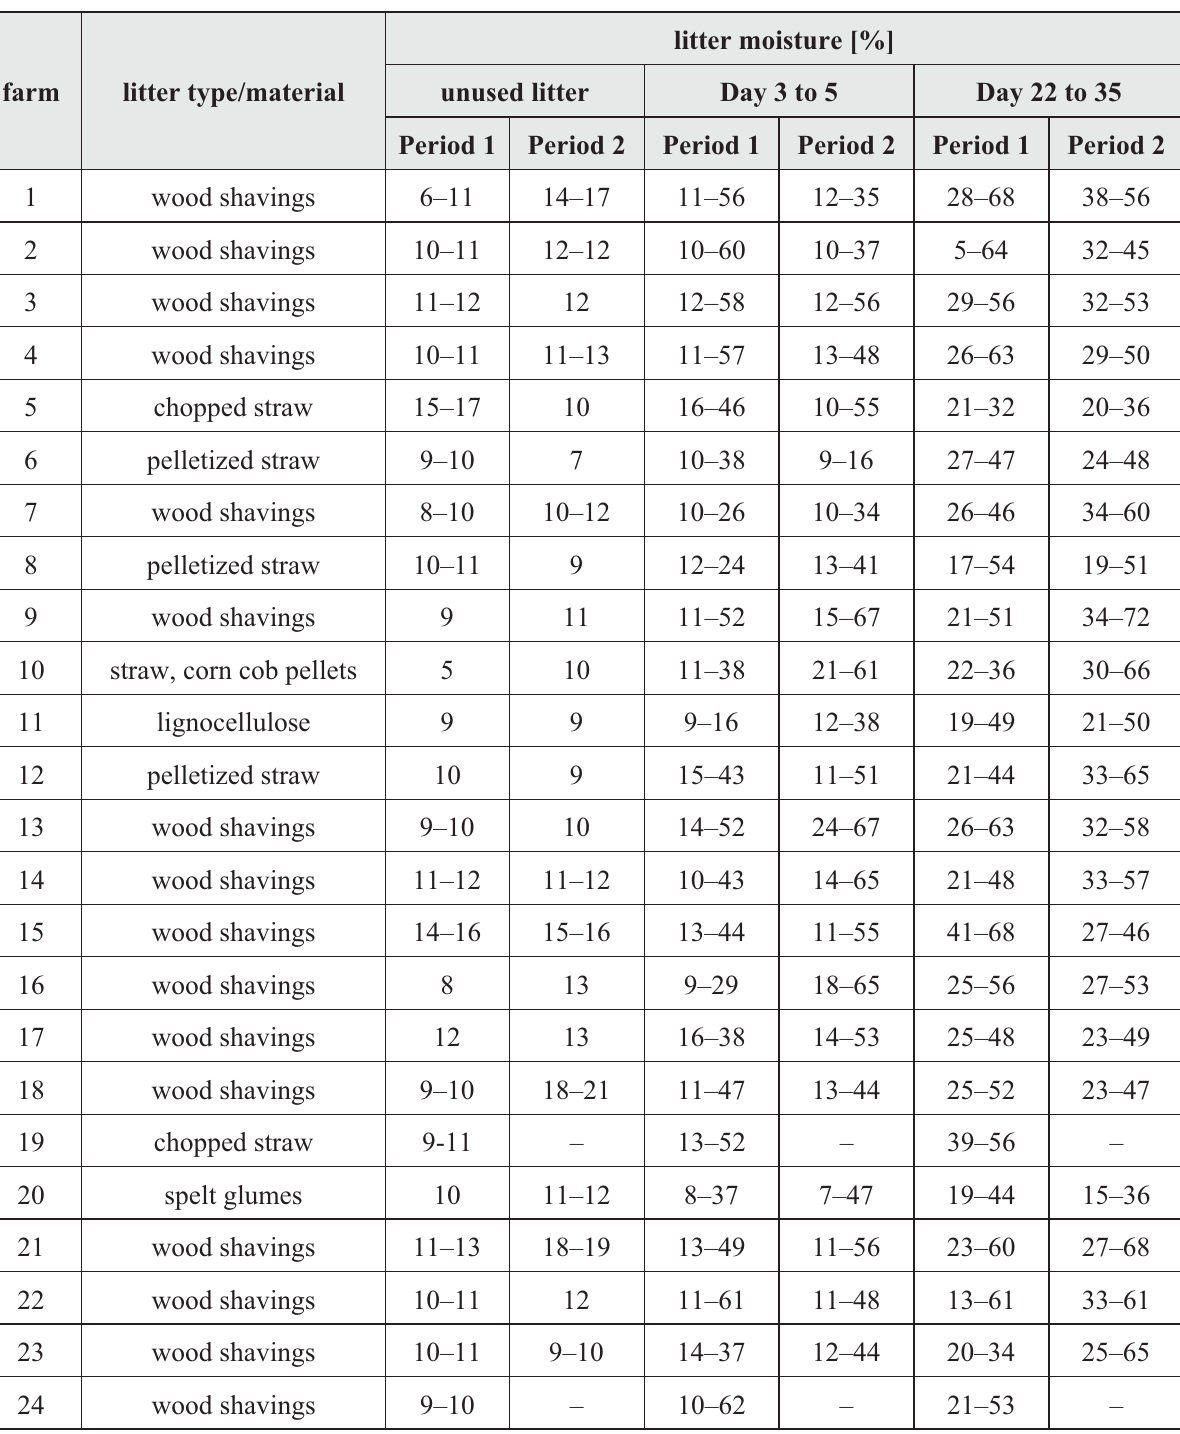
Table 5. Moisture values of the litter materials examined before usage (base value), Day 3 to 5 and Day 22 to